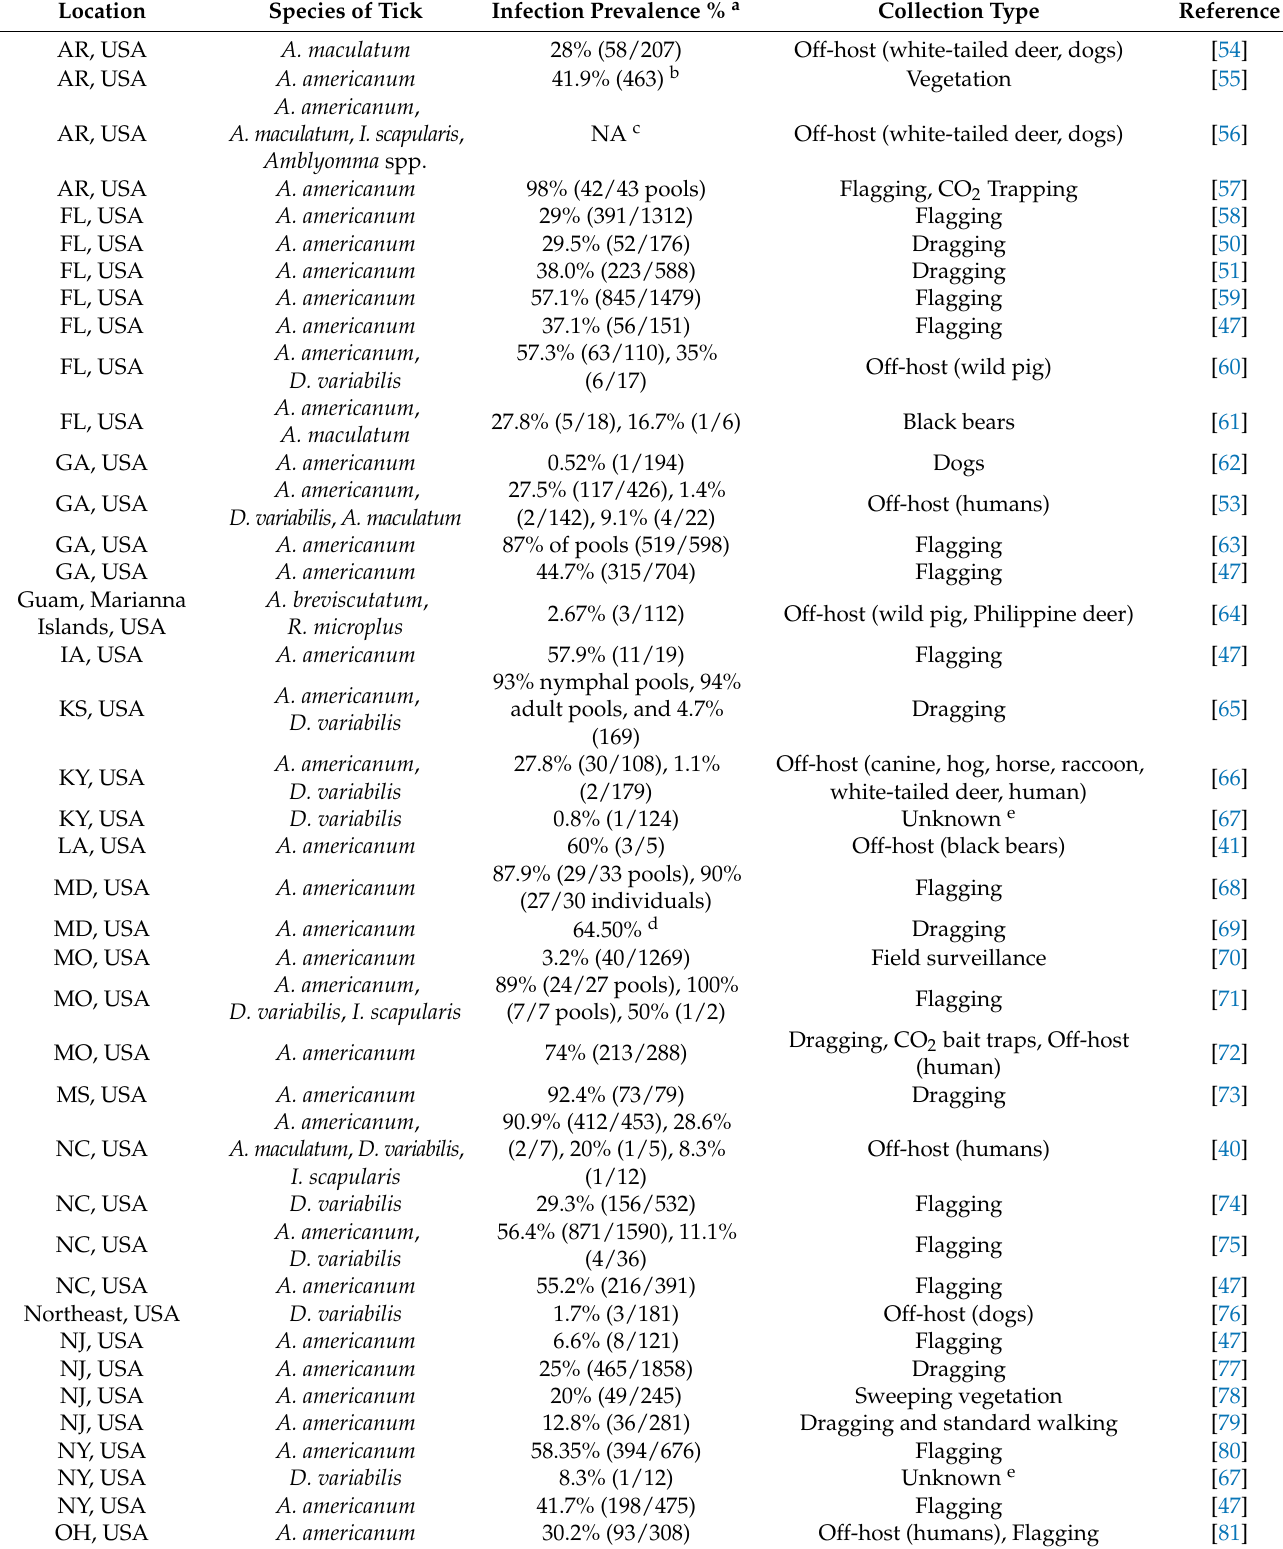
Table 1. Summary of quantitative data obtained from peer-reviewed publications for R. amblyommatis - infected wild ticks collected globally. This table includes the location in which they were collected, the species of tick, the infection prevalence, and the collection type. Studies were included if R. amblyommatis was confirmed through conventional PCR and sequencing